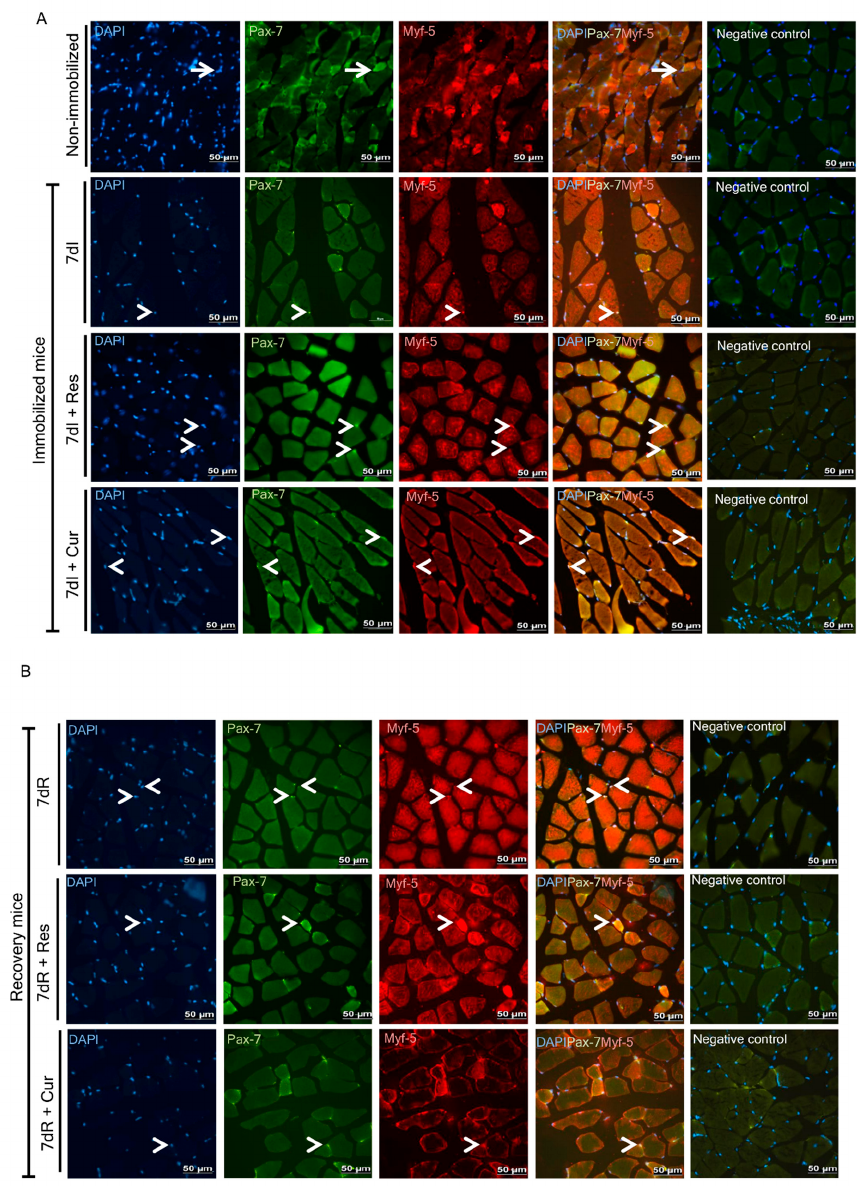
Figure 5. ( A ) Representative images of immunofluorescence staining of DAPI (left panels), Pax-7 (middle-left panels), Myf-5 (middle panels) and cells positively stained for both Pax-7 and Myf-5 markers (middle-right panels), and negative control (right panels) in the gastrocnemius muscle of the non-immobilized mice and immobilized mice with and without treatment (7dI, 7dI + Res and 7dI + Cur groups of mice). Thin arrows indicate Pax-7-positive cells, and arrowheads indicate double-stained nuclei for both Pax-7- and Myf-5-positive cells (activated satellite cells). Definition of abbreviations: Pax-7, paired box-7; Myf-5, myogenic factor 5; DAPI, 4’,6-diamino-2-fenilindol; I, immobilization; Res, resveratrol; Cur, curcumin. ( B ) Representative images of immunofluorescence staining of DAPI (left panels), Pax-7 (middle-left panels), Myf-5 ((middle panels) and cells positively stained for both Pax-7 and Myf-5 markers (middle-right panels) and negative control (right panels) in the gastrocnemius muscle of the recovery mice with and without treatment (7dR, 7dR + Res and 7dR + Cur groups of mice). Thin arrows indicate Pax-7-positive cells, and arrowheads indicate double-stained nuclei for both Pax-7- and Myf-5-positive cells (activated satellite cells). Definition of abbreviations: Pax-7, paired box-7; Myf-5, myogenic factor 5; DAPI, 4’,6-diamino-2-fenilindol; R, recovery; Res, resveratrol; Cur,